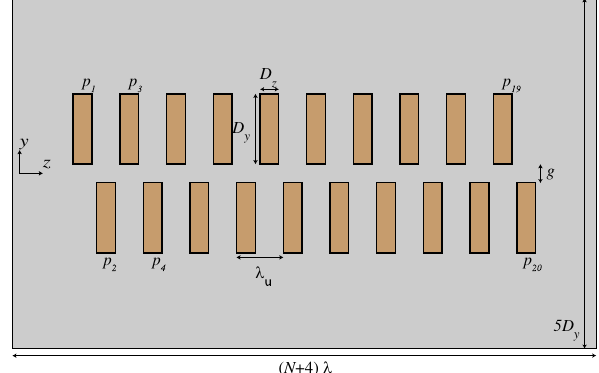
FIG. 3. Simulation geometry for the inverse analysis. Twenty bulks having different parameters, p , are aligned in a large air i domain. The z -direction solenoid field is applied to the top and bottom boundaries and a perfect magnetic field constraint (such that n × H ¼ 0 ) is applied to the left and right boundaries.